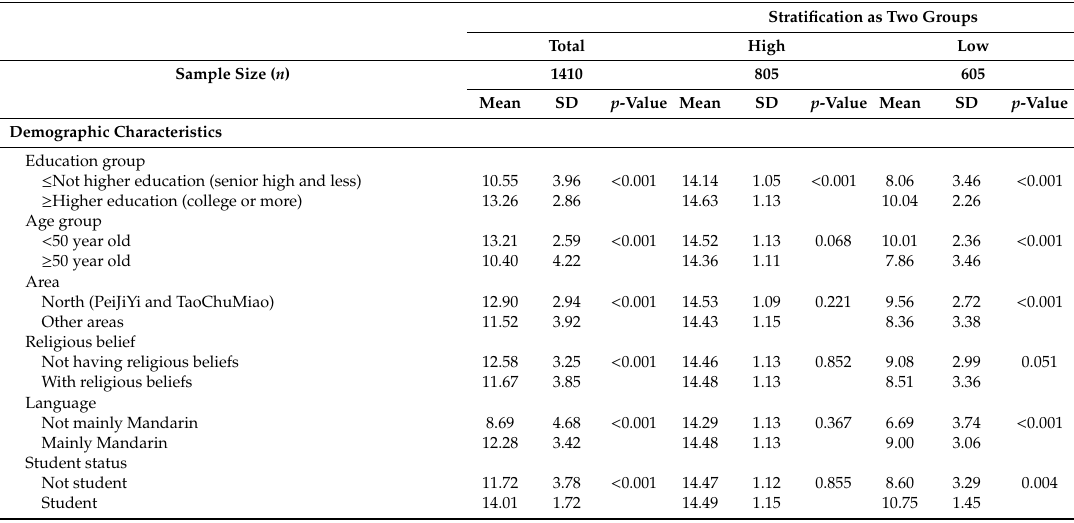
Table 4. Bivariate analyses of the ChMLM-17 total score across groups with di ff erent levels of medication literacy and